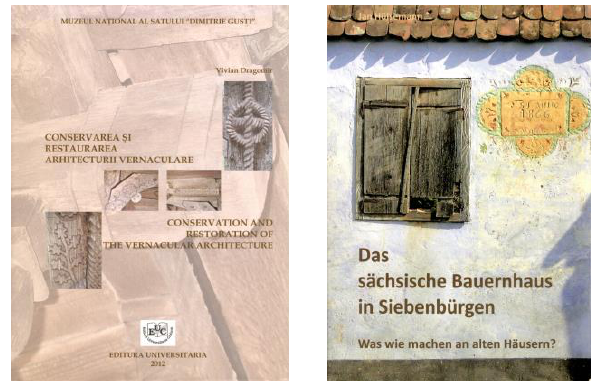
Figure 16. examples of publications driving forces for local